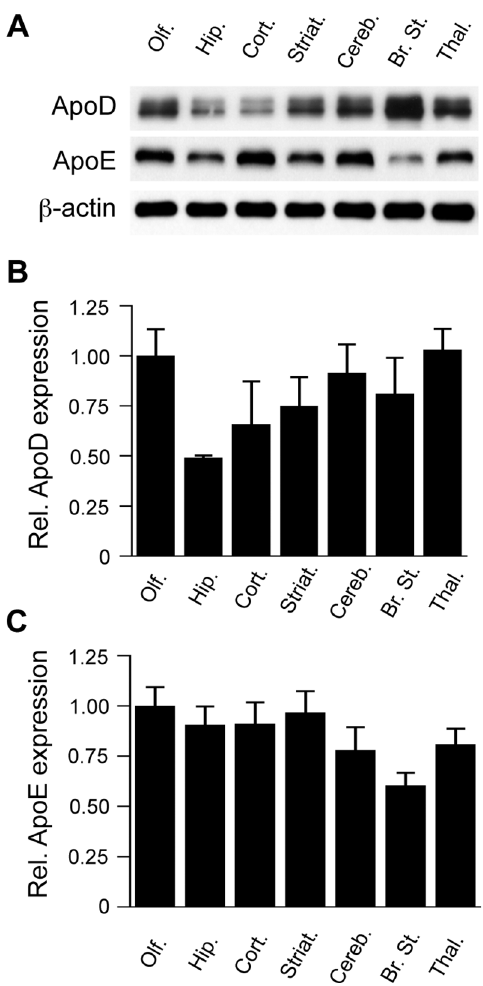
Fig 1. Expression of apoD and apoE in mouse brain regions. The indicated regions of mouse brain were homogenized and assessed for apoD and apoE by western blotting after controlling for equal total protein loading. Levels of β -actin were similar across the brain regions and were therefore used as a housekeeper control protein to normalize apoD and apoE expression. Representative blots are shown from an ~8 month- old male mouse (A). Histograms indicate the relative expression of apoD (B) and apoE (C), corrected for β - actin levels. Data in “ B ” and “ C ” are relative optical density measurements where the olfactory bulb is arbitrarily defined as 1.0. The data are derived from 3 different animals (mean values, SE shown by the error bars). Olf., olfactory bulb; Hip., hippocampus; Cort., frontal cortex; Striat., striatum; Cereb, cerebellum; Br. St., brain stem; Thal.,